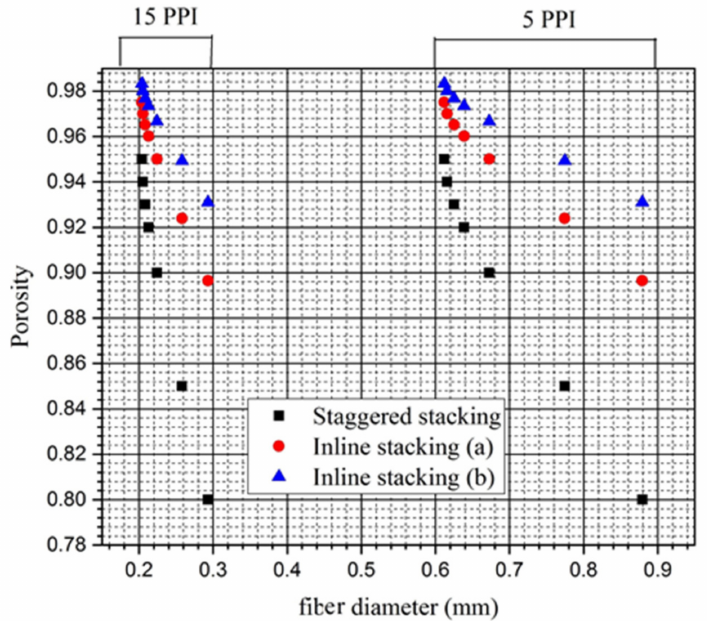
Figure 14. Variation of porosity with respect to change in fiber diameter for various stacking of wire-mesh screens of given pore density or mesh size (pores per inch/mesh per